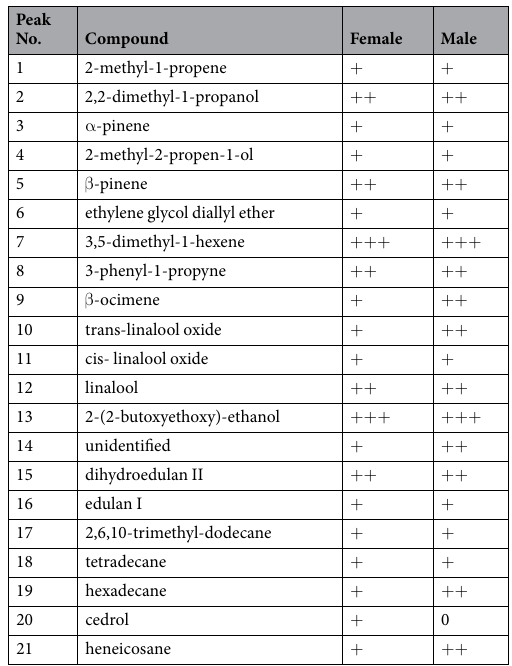
Table 1. Chemical volatiles recovered from adult males and females of Cethosia cyane cyane . Significance levels: + = 0.01–1%, ++ = 1–20%, +++ = More than 20%.